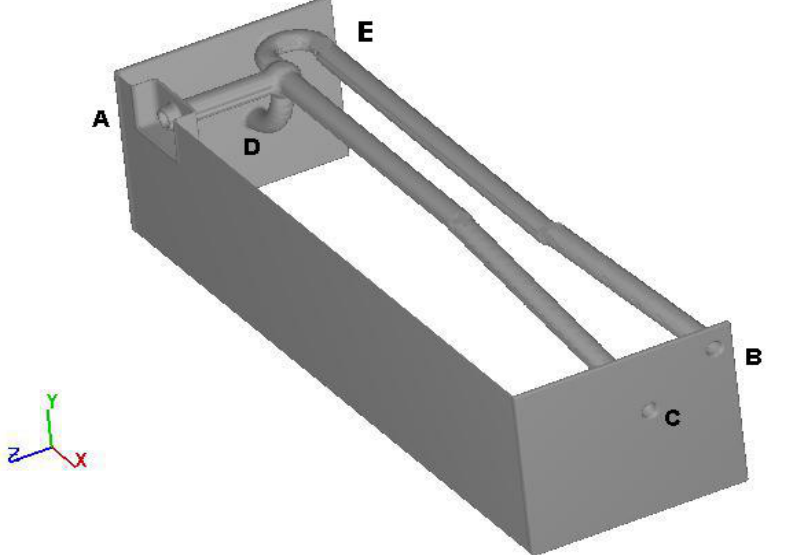
Figure 4. FLOW-3D CFD model of the pipeline connections constructed from Figure 3. Pipeline inner diameter ~15 cm. Figure from [2], p. 291.